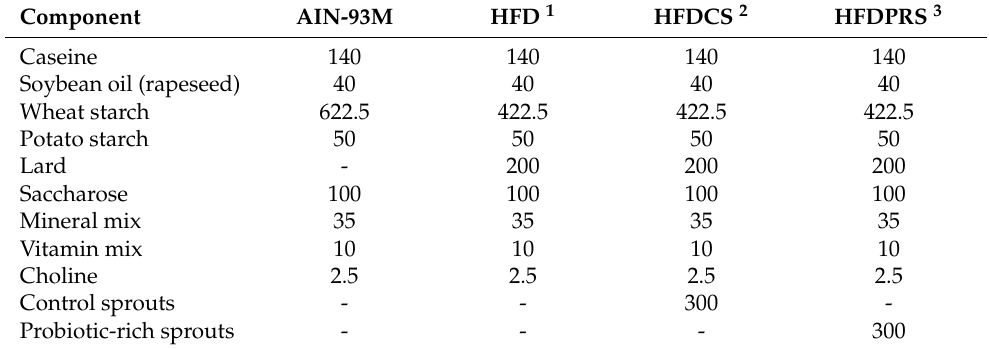
Table 6. Composition of experimental diets (g/kg—AIN-93M, HFD diet; g/1.3kg—HFDCS, HFDPRS. Component AIN-93M HFD 1 Caseine 140 140 40 Wheat starch